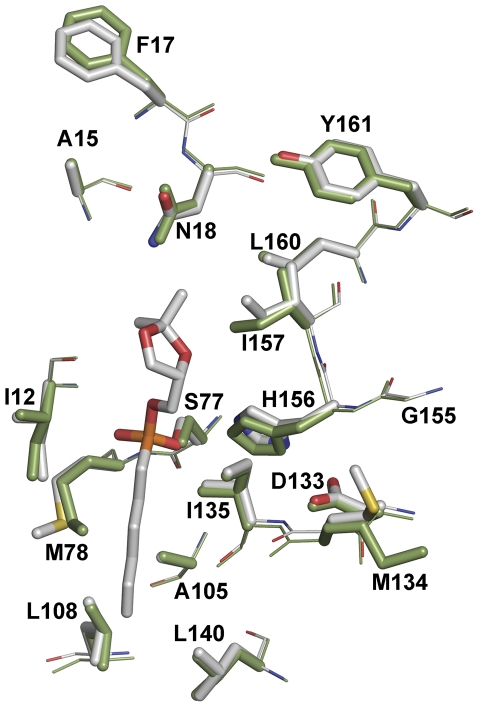
Active site in transition state bound and free form.Structural overlap of active site of the free wild type lipase and in complex with covalently attached transition state analog (chain A of PDB id: 1I6W and 1R4Z). Transition state analog is O-[(R)-1,2-O-isopropylidene-sn-glycerol]6-hexenyl phosphonate [34]. Free enzyme is shown in green while complex is shown in elemental color. Side chains are shown as sticks while backbone as lines. Stereo figure is shown in Fig. S6.